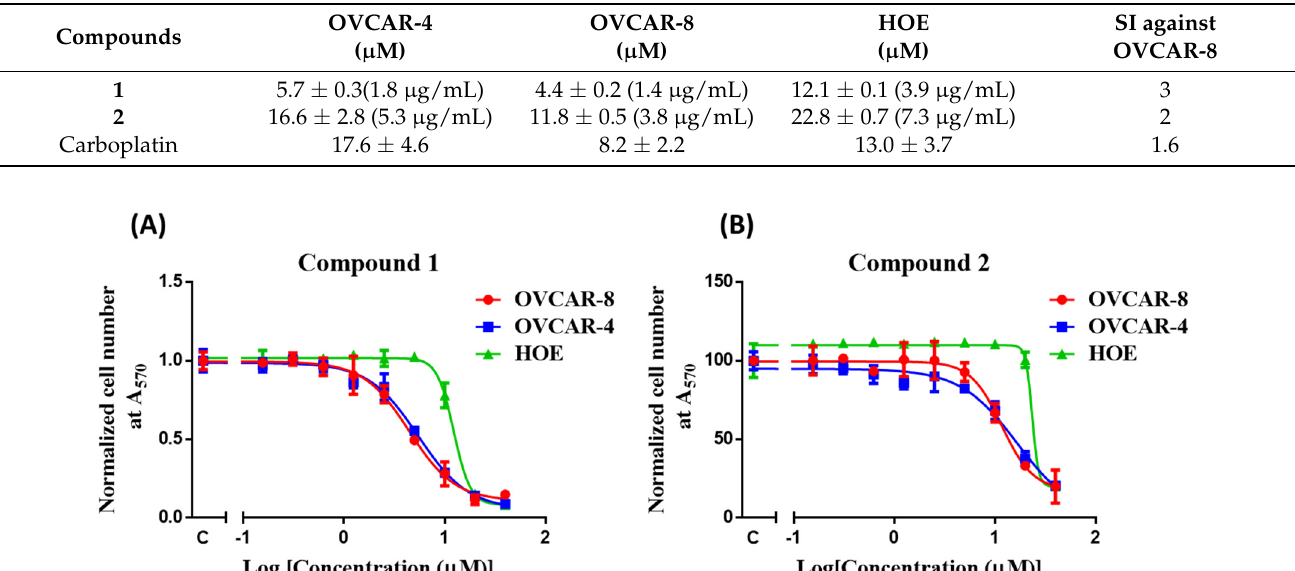
Figure 1. Chemical structure of compound 1 , 16( α / β )-hydroxy-cleroda-3,13 (14) Z -dien-15,16-olide, Table 1. The growth inhibitory activities of isolated compounds ( 1 and 2 ) from J. insularis in OVCAR-4, OVCAR-8 cancer cell lines and HOE cells. The selectivity index (SI) (the ratio of IC 50 against HOE cells to IC 50 against OVCAR-8) are indicated. Compounds